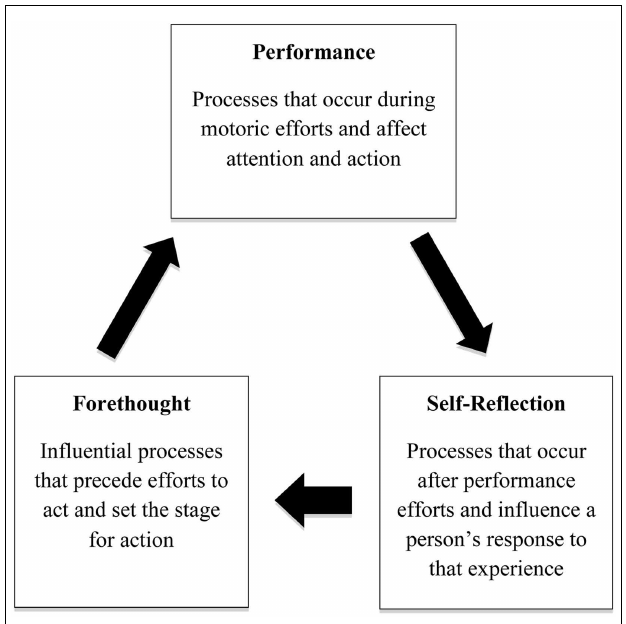
FIGURE 1 | Zimmerman’s (2000) cyclical model of